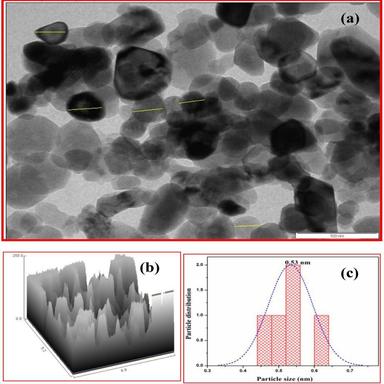
HR-TEM analysis of CdO-SnO2 nanocomposite material (a) Image CdO-SnO2 nanocomposite material (b) Surface plot and (c) particle size in selected area highlighted fig (a).